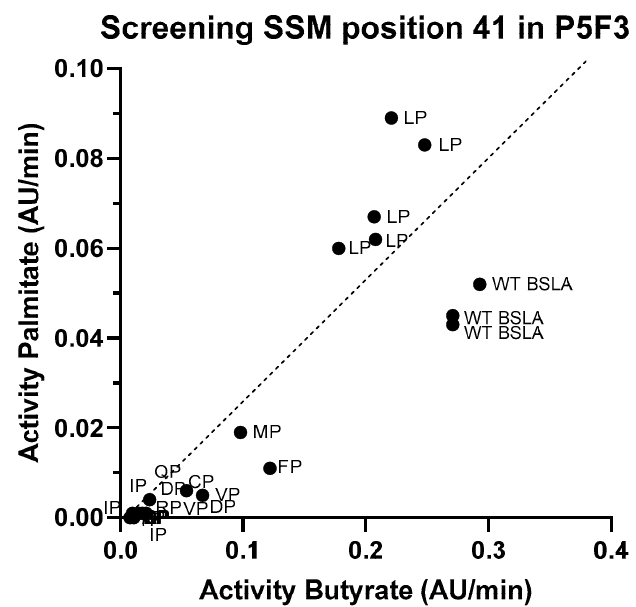
Figure 4. Screening results for the site saturation mutagenesis in position 41 on variant P5F3. After assessing hydrolytic activity against p -nitrophenyl butyrate and palmitate on the resulting library, and sequencing analysis of the best performing variants, results suggests that variant P5F3 (F41L- ∆ W42- ∆ D43-K44P) with the new LP amino acid pair in region 3 shows the highest activity against the longer fatty acid chain substrate.